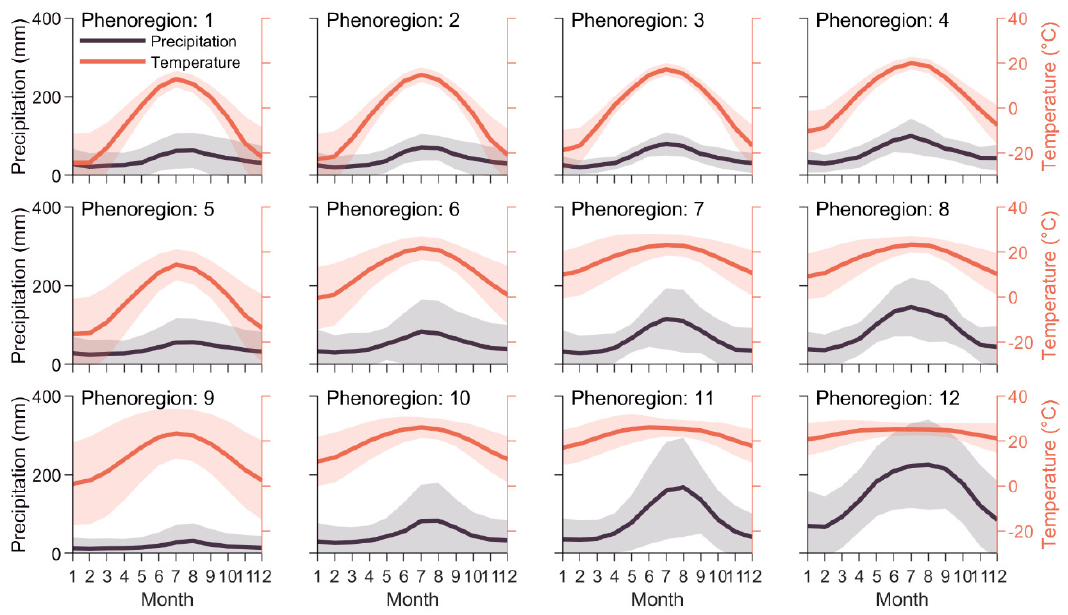
Figure 5. Mean temperature (red) and precipitation (gray), ± 1 standard deviation, within each of the 12 Level I phenoregions. To maintain consistent timing across hemispheres, the seasonal cycles shown above start in January for the Northern Hemisphere and July for the Southern Hemisphere.